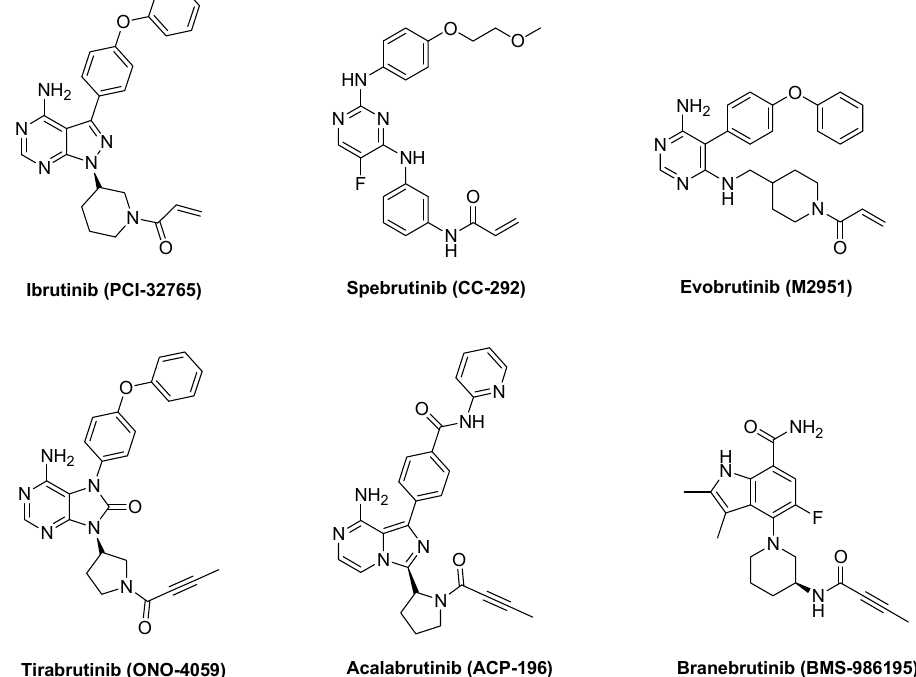
Figure 1. Representative irreversible BTK inhibitors.